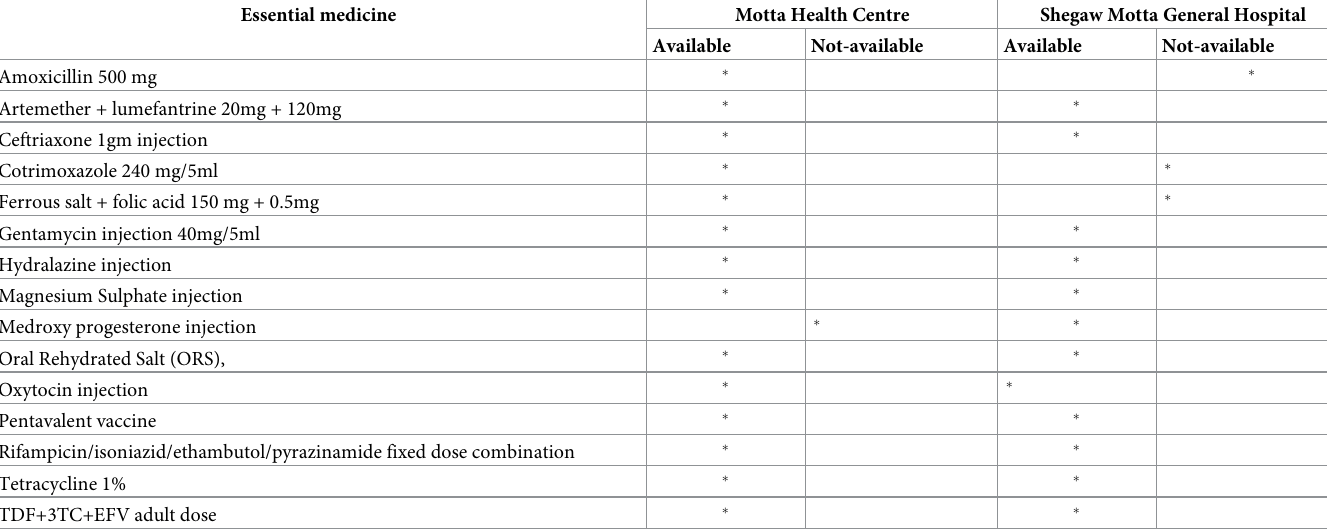
Table 3. Availability of each medicine in Shegaw Motta general hospital and Motta Health center at the date of the survey. Essential medicine